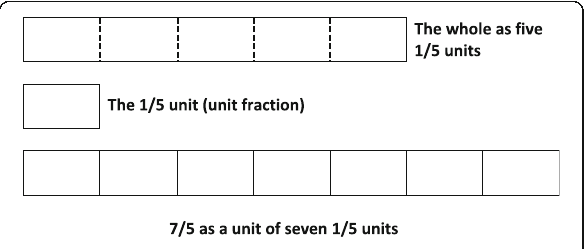
Fig. 5 7/5 as a unit of seven units of 1/5, five of which comprise the